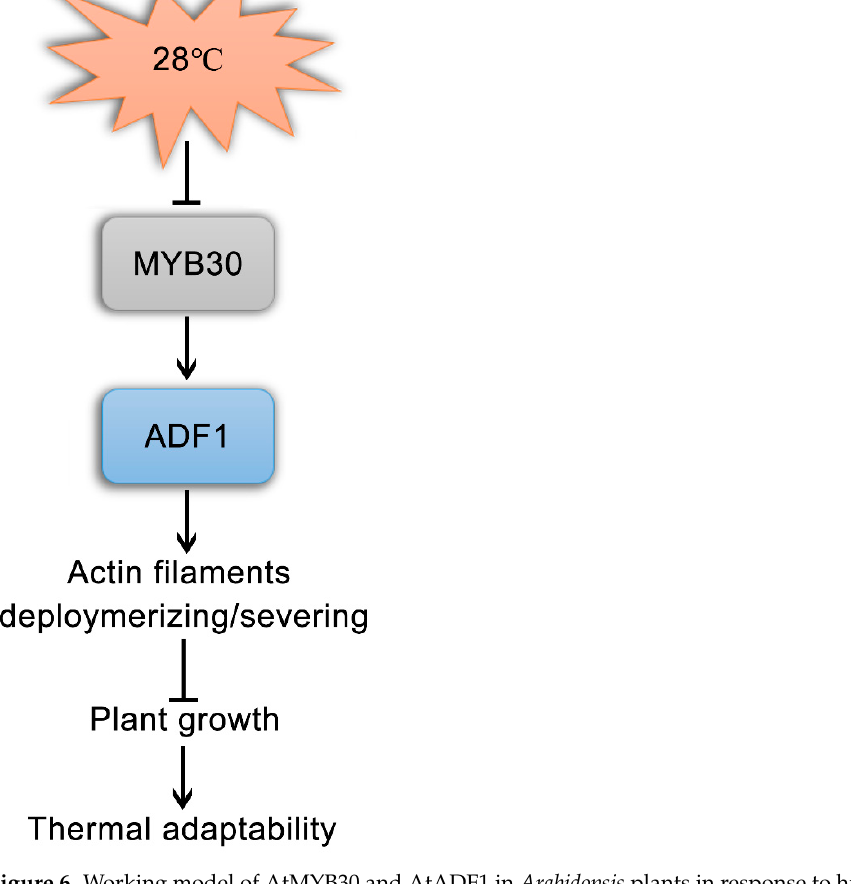
Figure 6. Working model of AtMYB30 and AtADF1 in Arabidopsis plants in response to high temperatures. Arrows represent positive regulation, and barred ends indicate inhibitory action. Details of this model are discussed in the text.